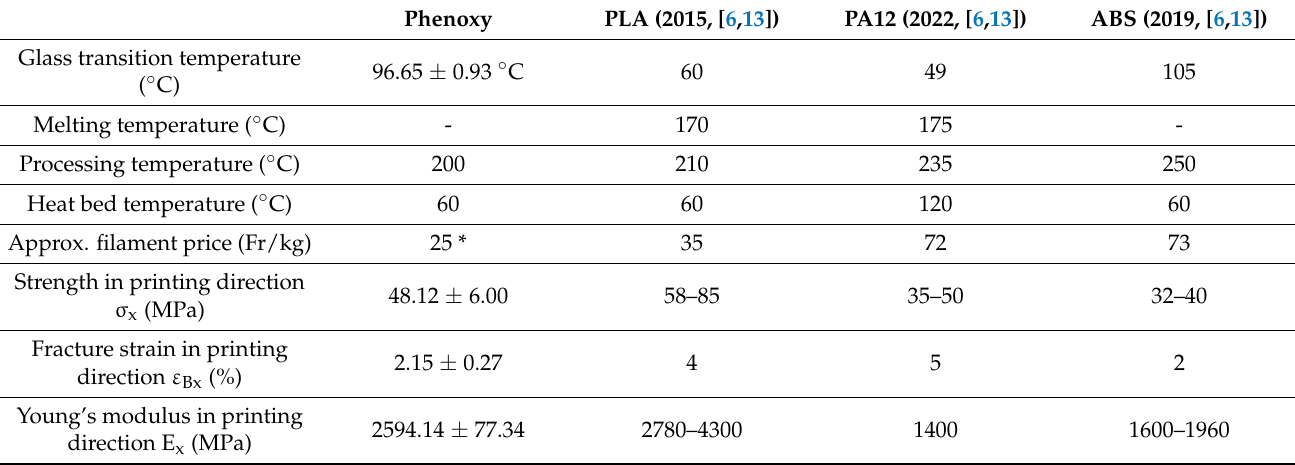
Table 5. Comparison between phenoxy and standard FFF materials.